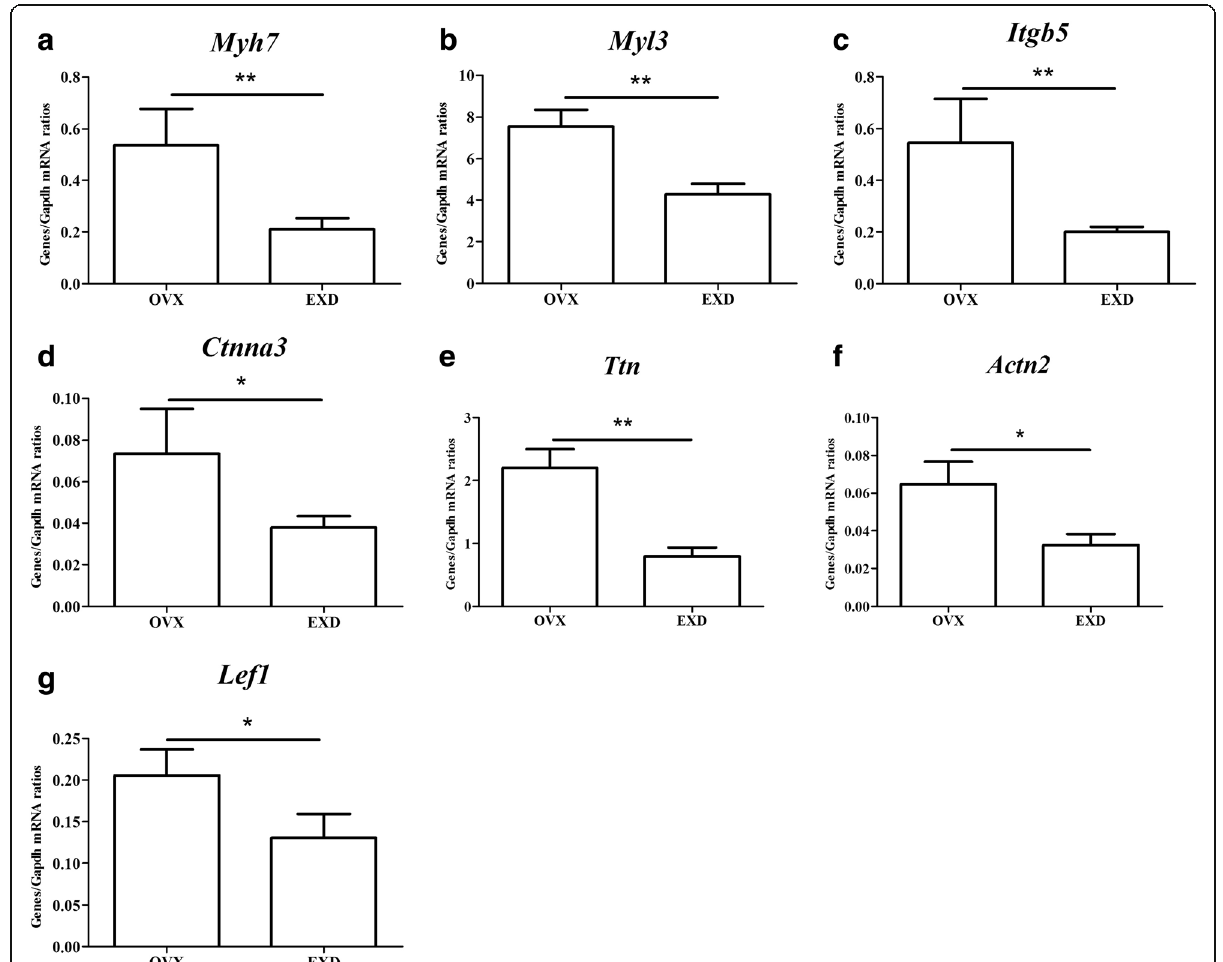
Fig. 6 Validation of 7 differential expression genes ( a : Myh7 ; b : Myl3 ; c : Itgb5 ; d : Ctnna3 ; e : Ttn ; f : Actn2 ; g : Lef1 ) identified by microarray and KEGG in a replicated experiment by qRT-PCR. * P < 0.05, ** P < 0.01, in comparison with the OVX